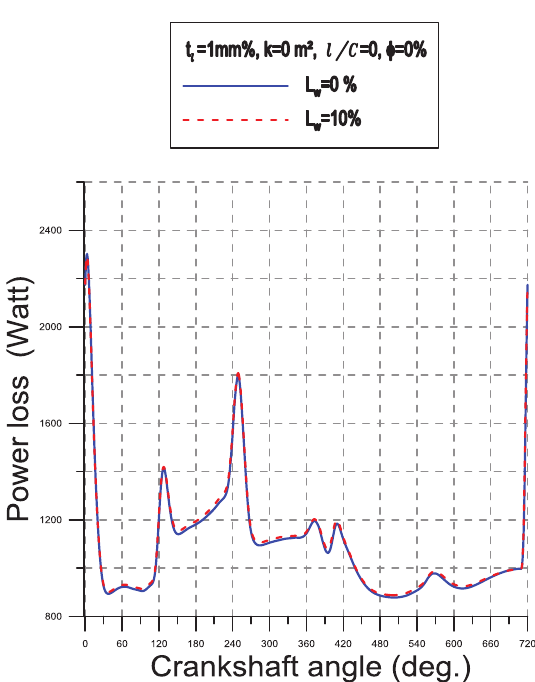
Fig. 12. Effects of dynamic misalignment on power loss over an entire cycle.